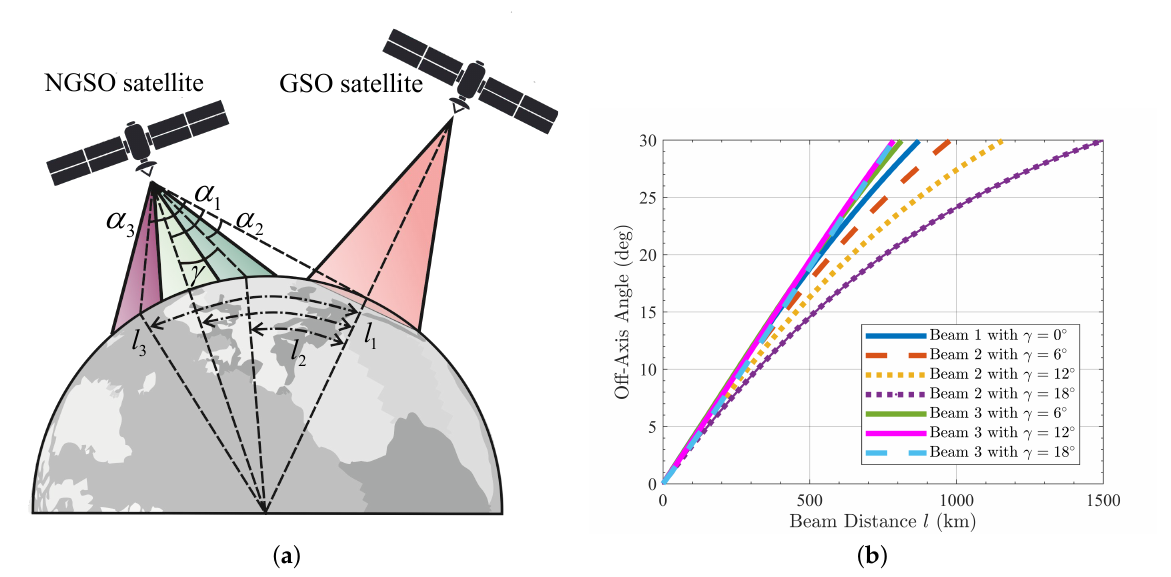
Figure 7. Downlink scenario where pointing of NGSO satellite beams have different tilting angles and relationship between off-axis angle and beam distance l with different tilting angles. ( a ) Pointing of NGSO satellite beams with different tilting angles; ( b ) Relationship between variation of off-axis angle and beam distance l when beams have different tilting